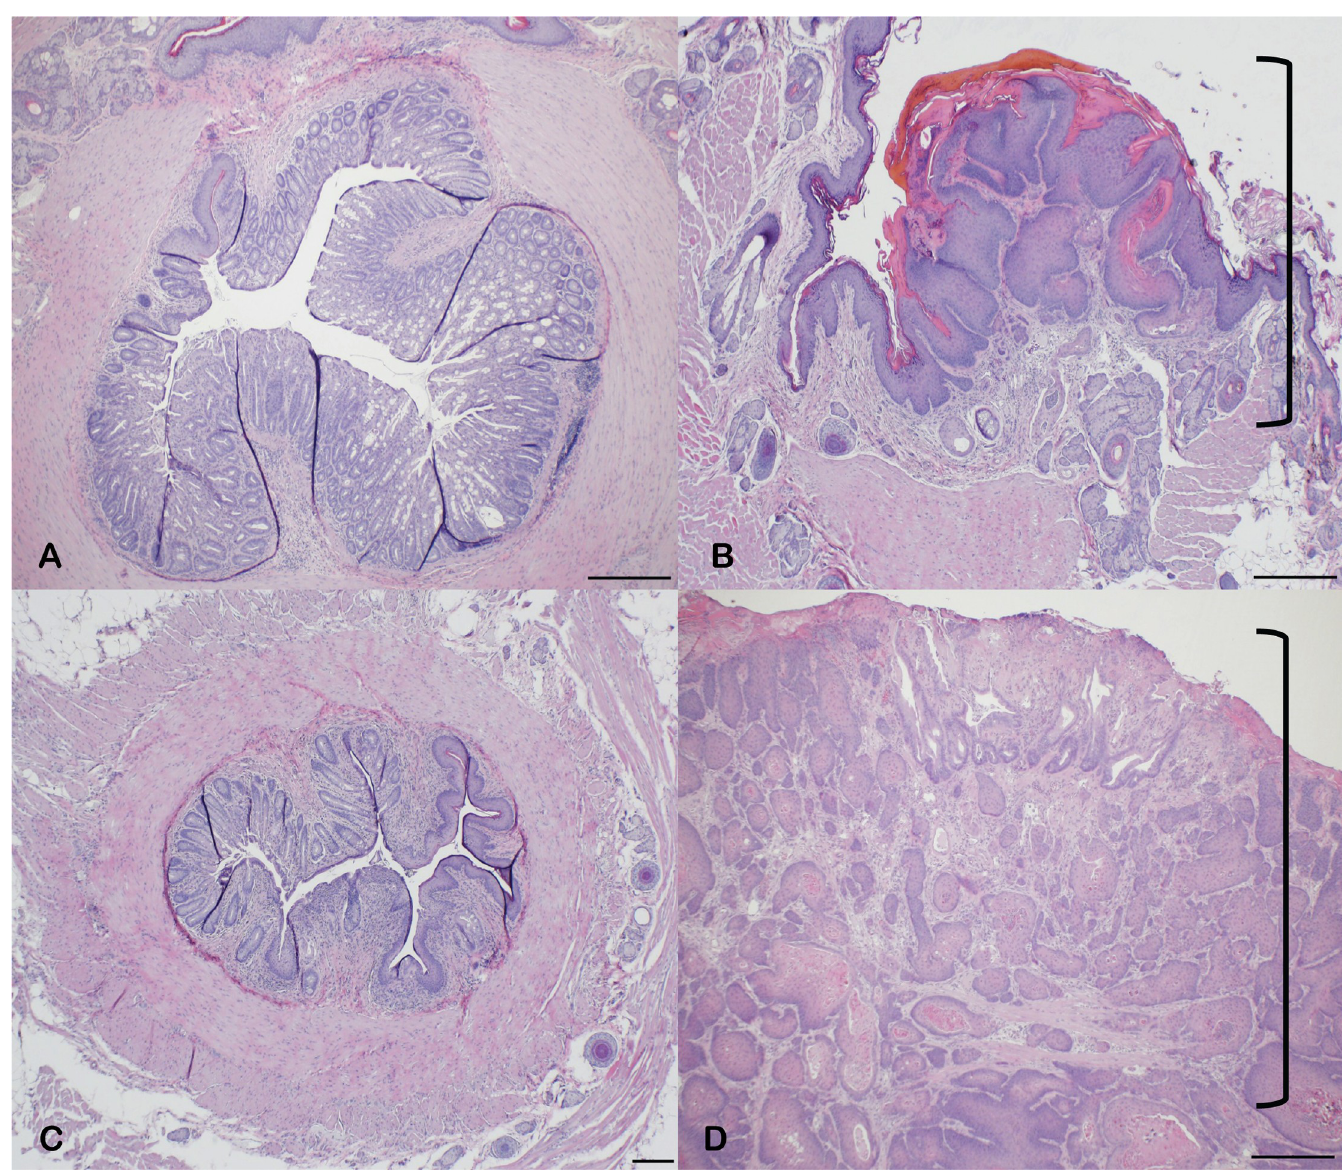
Fig 8. Estrogen dosed castrated KC male develop anal SCC. Castrated KC male mice and ovariectomized KC female mice were treated with 17-beta estradiol (E2) or sham (sesame oil). Sham dosed KC males did not develop anal SCC (A), while E2 dosing induced anal SCC in KC males (B, shown by bracket). Similarly, sham dosed KC females did not develop anal SCC (C) while E2 dosing rescued the anal SCC phenotype in KC females (D, shown by bracket). Scale bars equal 200 μ m.